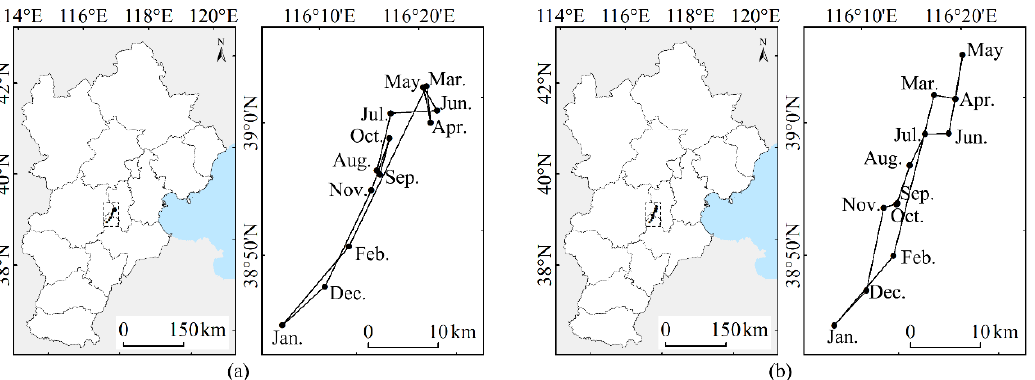
Figure 10. Movement trajectory of the centres of gravity of the monthly mean values of PM 2.5 ( a ) and PM 10 ( b ) concentrations.